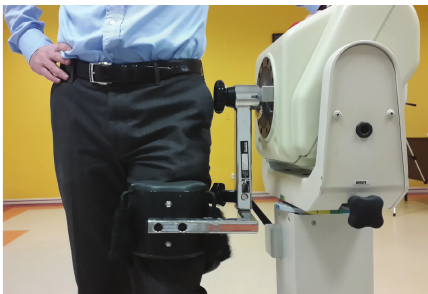
Figure 2: The hip muscle strength measurement by using Biodex System 3 Dynamometer. The flexion and extension muscle forces were measured at standing position.